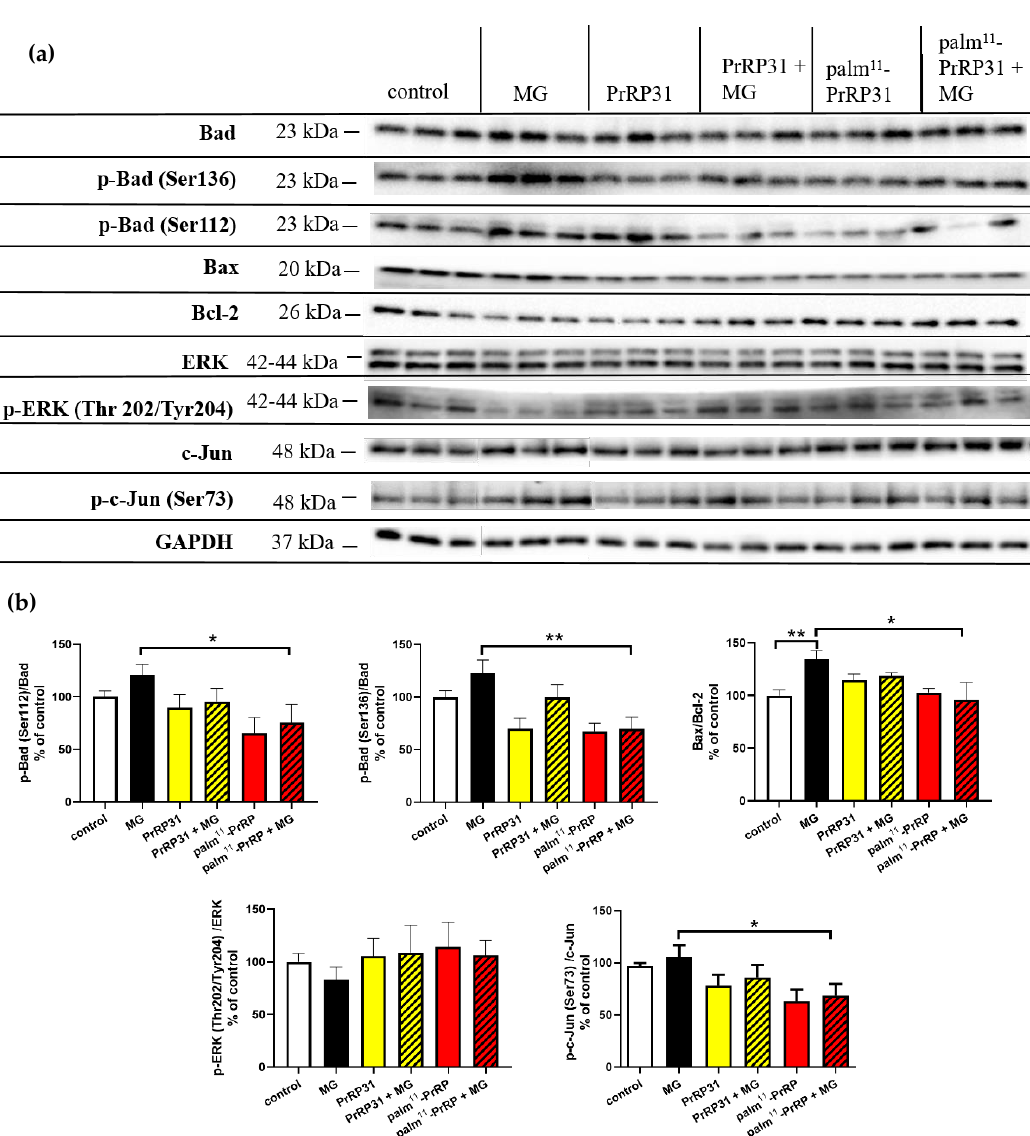
Figure 7. PrRP31 and palm 11 -PrRP31 affected anti-apoptotic signaling in SH-SY5Y cells. Immunoblots: ( a ) and their quantifications: ( b ). SH-SY5Y cells were pretreated with PrRP31 and palm 11 -PrRP31 at a concentration of 1 × 10 − 5 M for 4 h and then stressed with 0.6 mM MG for 16 h. Activation was expressed as the ratio of the activated protein to the total amount of the protein, both normalized to loading control, GAPDH. Data are presented as the means ± SEM as a percentage of control cells treated with medium alone. Analysis is made vs. MG by a Student’s t -test, * p < 0.5, ** p < 0.01 (each sample in triplicates).